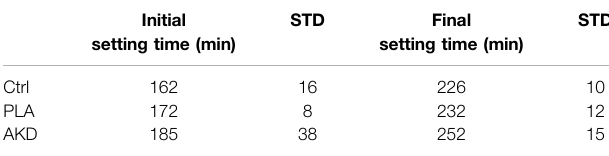
TABLE 7 | Initial and fi nal setting time (average of three